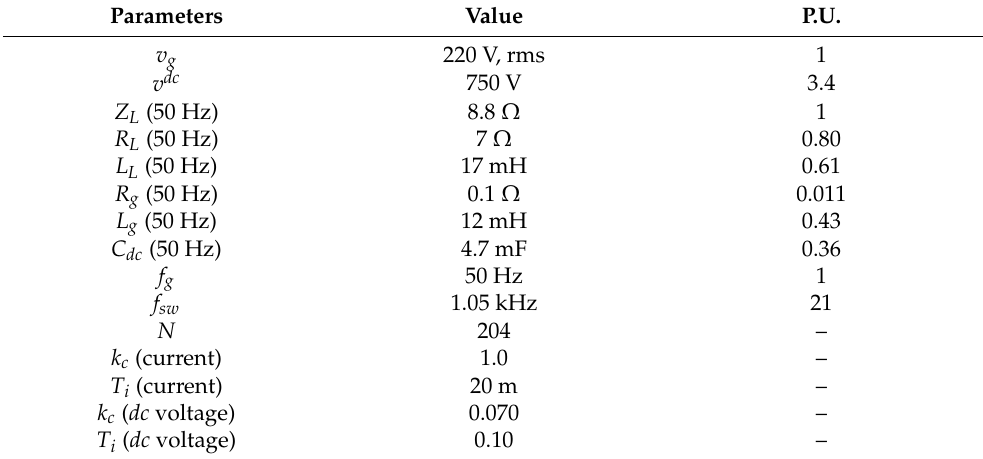
Table 1. System parameters.